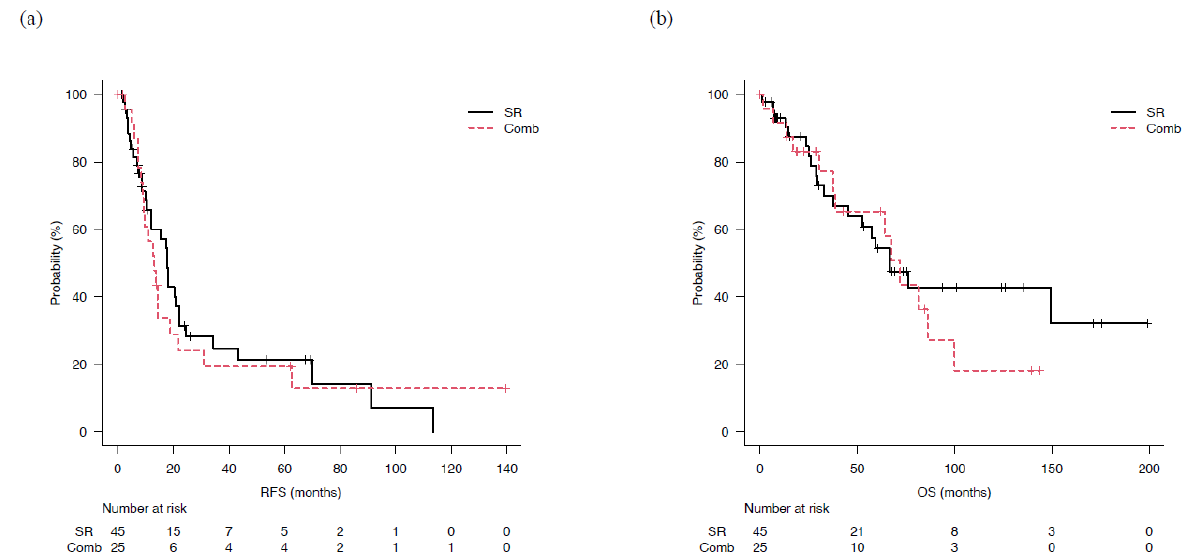
Figure 2. Recurrence-free and overall survival for patients who underwent surgical resection (SR) or combined surgical resection and radiofrequency ablation therapy (Comb). ( a ) There was not significantly difference of median recurrence-free survival (mRFS) in the SR (17.7 months, 95%CI: 10.3–22.1) and Comb groups (13.1 months, 95% CI: 9.0–18.9) ( p = 0.70). ( b ) Median overall survival (mOS) of the SR and Comb groups was 66.6 (95% CI: 37.7-not applicable) and 72.0 (95% CI: 37.5–100) months, respectively, not significantly different ( p = 0.544).